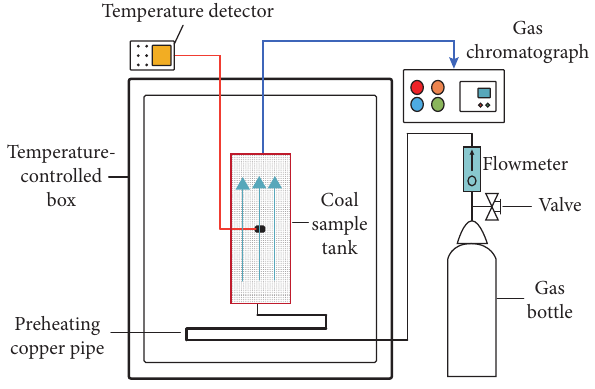
Figure 4: Scheme of the experimental system [8].